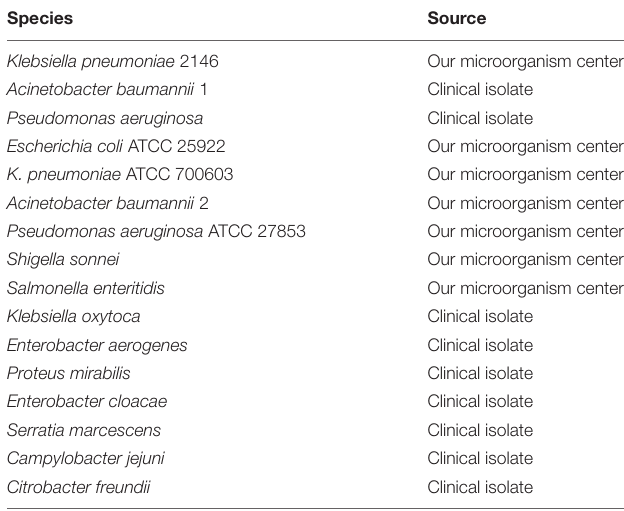
TABLE 1 | Bacterial types used in this